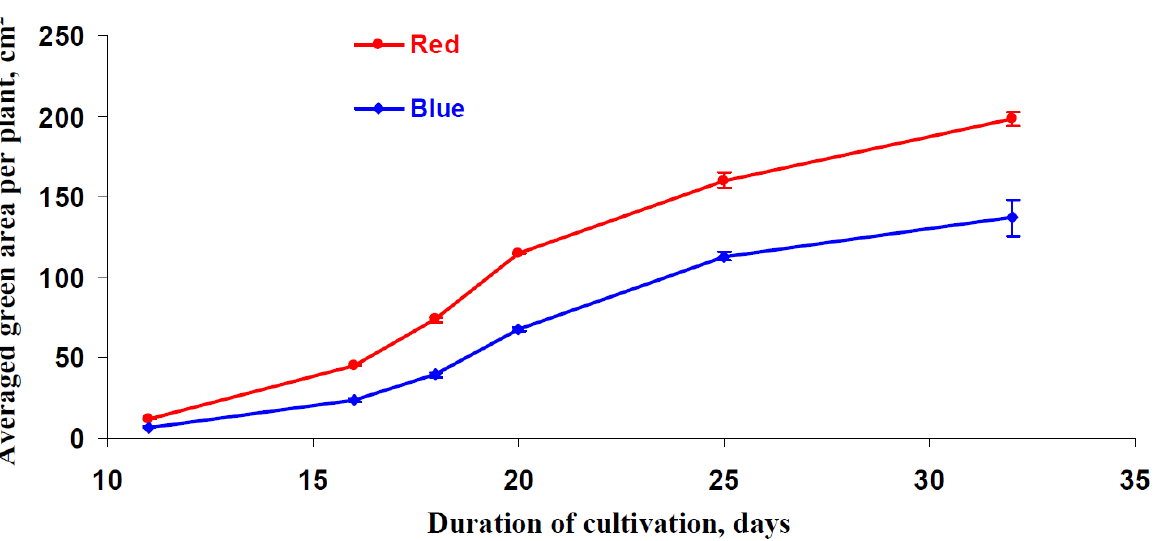
Figure 9. The dependence of the averaged green area per plant on duration of lettuce cultivation under the red (marked as “Red”) and blue (marked as “Blue”) illumination variants (see Figure 1).